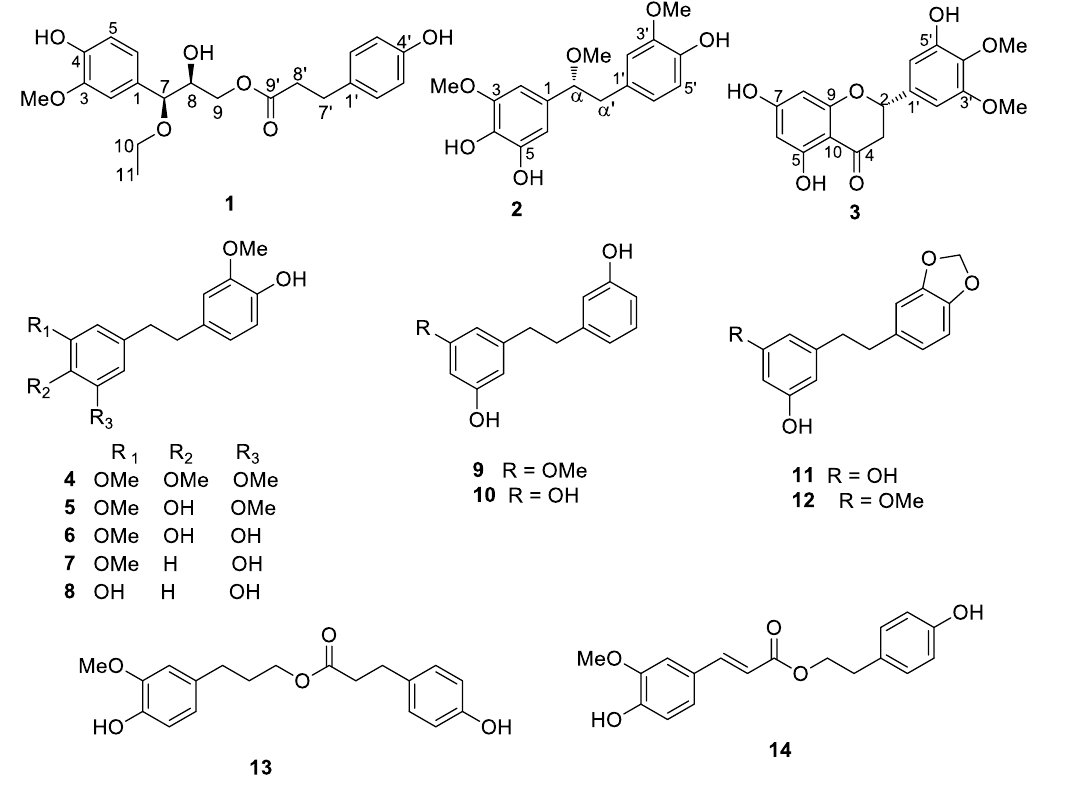
Fig. 1 Chemical structures of compounds 1 –